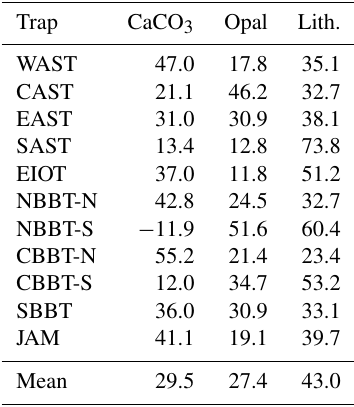
Table 8. Contribution of the individual ballast minerals to the pre- dicted POC flux (RIB see Eq.